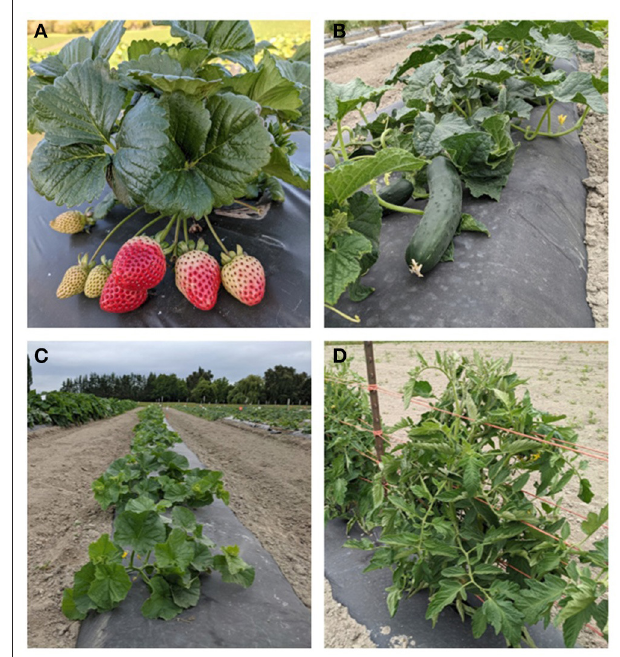
FIGURE 1 | Specialty crop production systems using raised beds covered with polyethylene mulch (A) strawberry, (B) cucumber, (C) pumpkin, and (D) tomato (photos by Brenda Madrid and Lisa W.